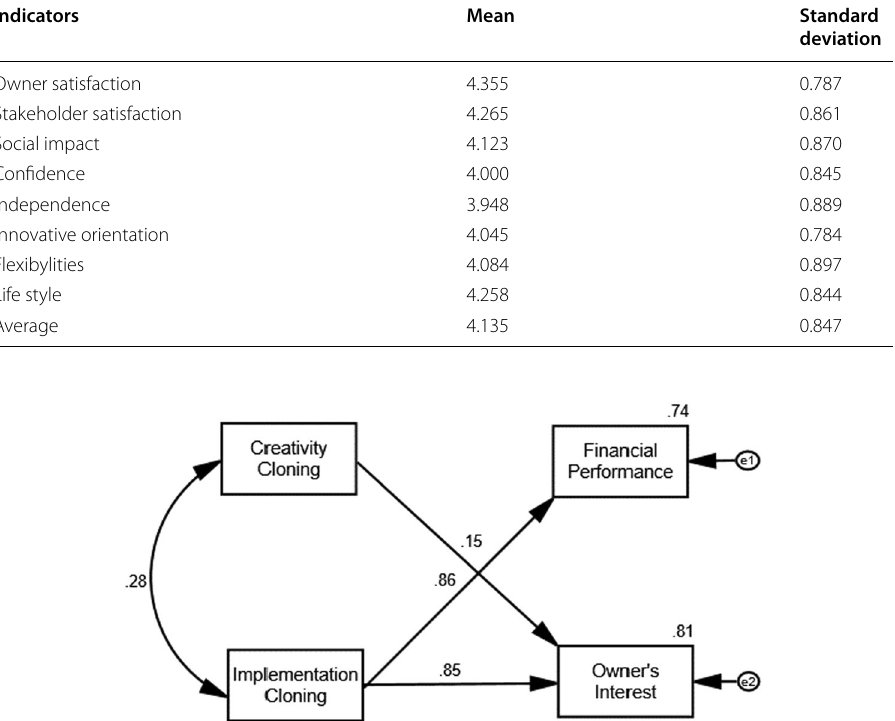
Table 7 Mean score business success in owner’s interest